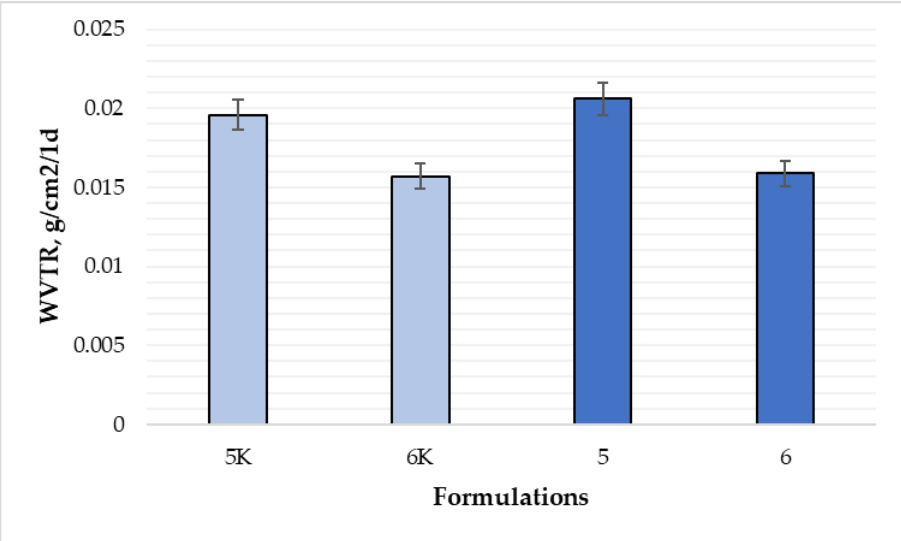
Figure 14. Comparison of average water vapor permeation through the film by composition (n = 3). The composition values are given in Table 1. p < 0.05 between compositions 5 and 6; p > 0.05 between 5 and 5K; 6 and 6K compositions.